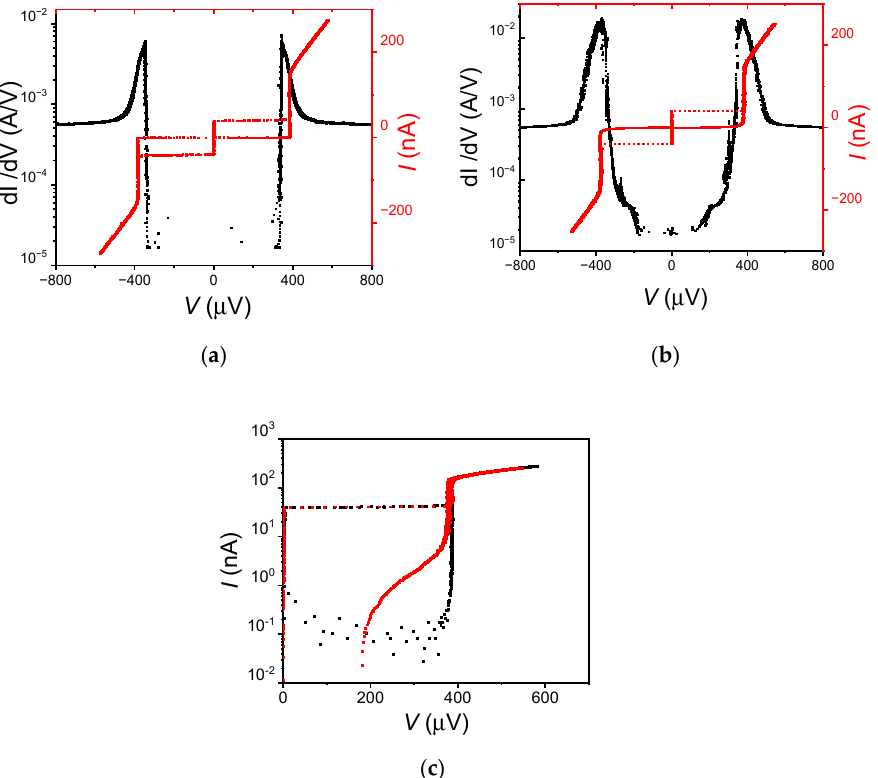
Figure 3. ( a ) Conductance dI/dV measurement and I–V curve for the SIS’S junction with a diameter of 4 µ m; ( b ) conductance measurement and I–V curve for the SIS’FS junction with a diameter of 4 µ m. The conductance measurements were performed by applying a magnetic field of 10 mT to suppress the Josephson supercurrent. ( c ) Magnification of the positive part branch of the I–V curve in a log-scale for both the SIS’S (black curve) and the SIS’FS (red curve) junction with a diameter of 4 µ